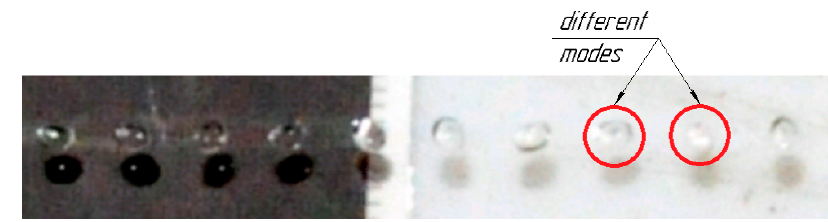
Figure 3. Droplet oscillation modes for the frequency of 510 Hz.